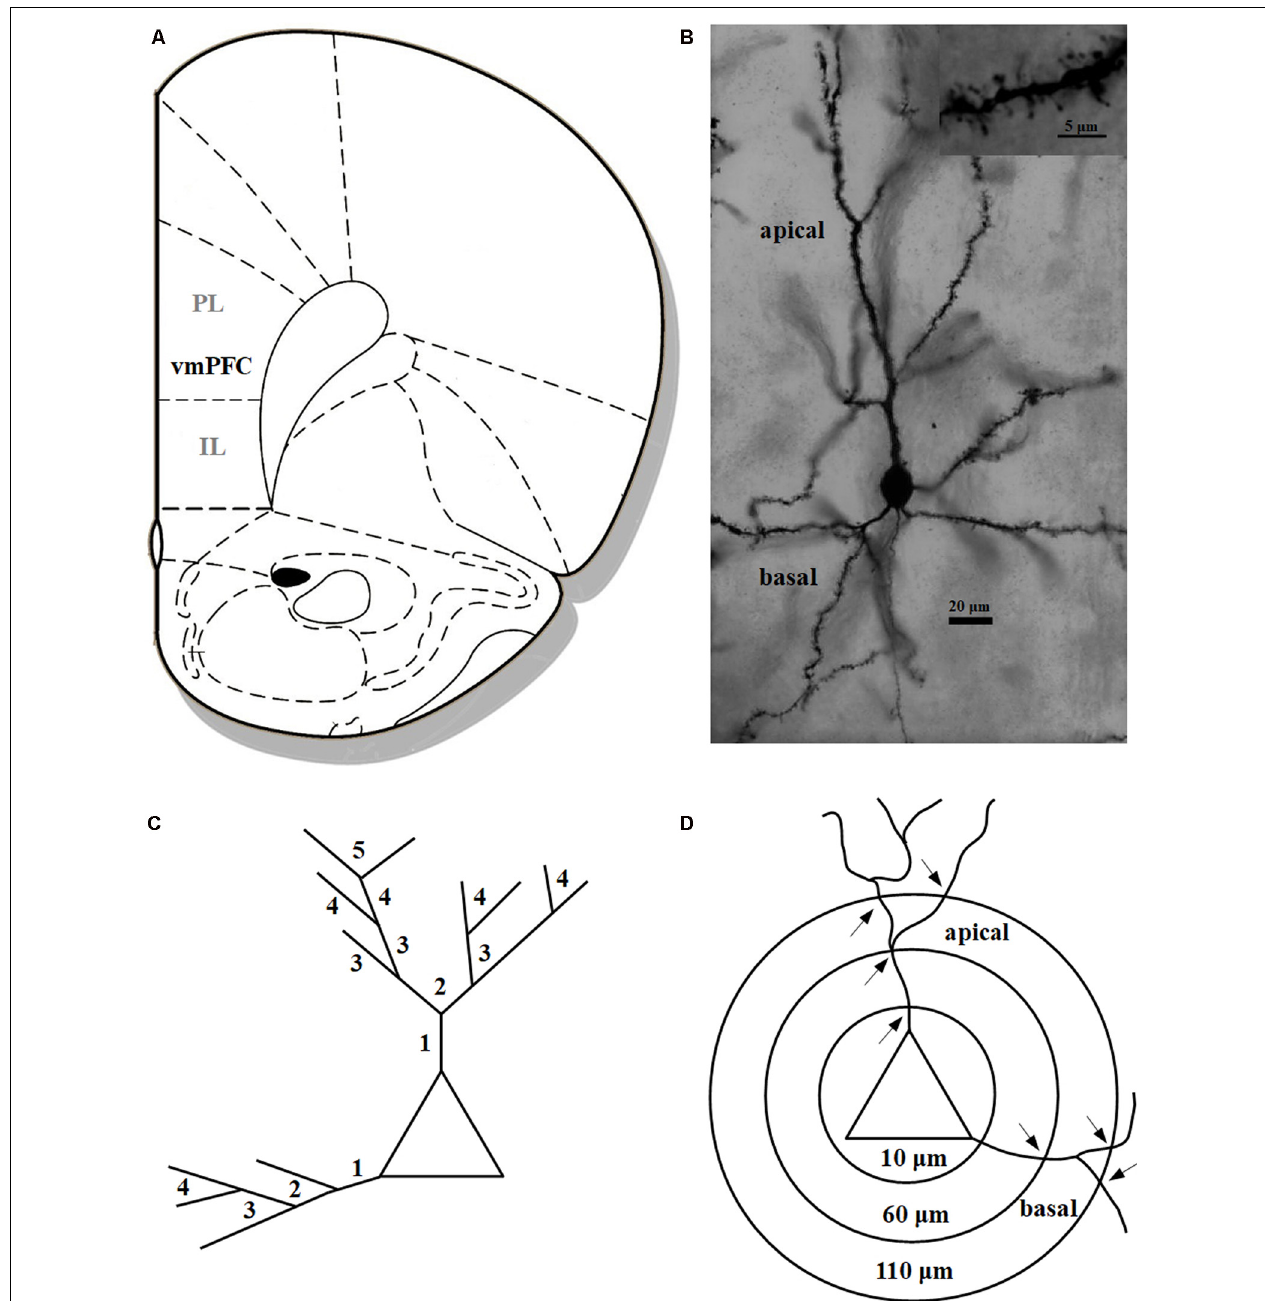
FIGURE 1 | (A) Schematic illustration indicating the vmPFC in the Degu cortex comprising the infralimbic (IL) and prelimbic (PL) cortex (modified after Paxinos and Watson, 2004); (B) photomicrograph of a pyramidal neuron in the vmPFC; inset shows a dendritic segment with dendritic spines; (C) schematic illustration of dendritic branching with numbers indicating individual branch orders (“natural” dendritic segments); (D) schematic illustration of Sholl analysis with concentric spheres around the soma and respective radii in µ m; arrows indicate intersections on apical and basal dendrites (“artificial” dendritic segments), respectively, used for the analysis of dendritic